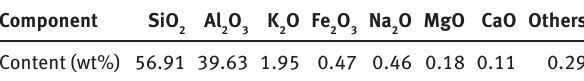
Table 1: The chemical compositions of raw kaolin. Component